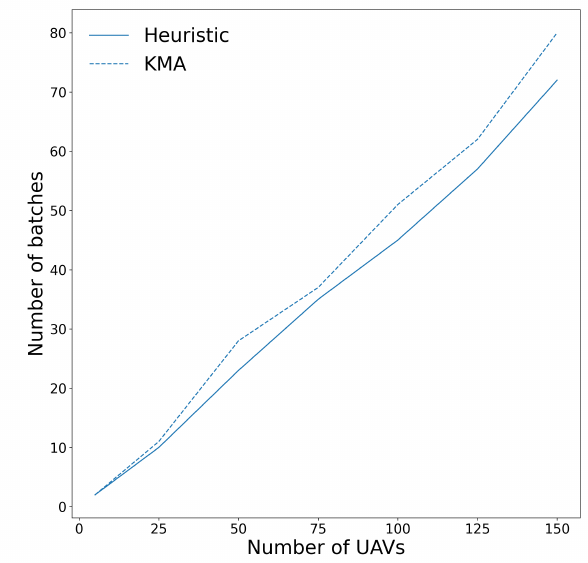
Figure 25. Number of batches between heuristic and KMA in the linear